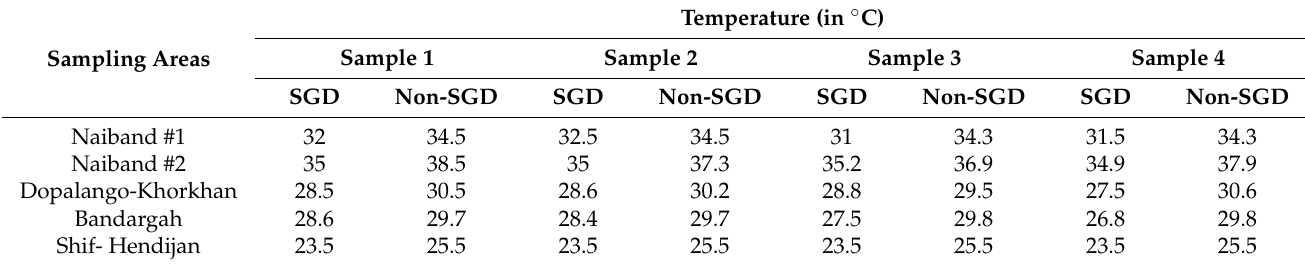
Table 2. In situ measurement of temperature in SGD and non-SGD sites.